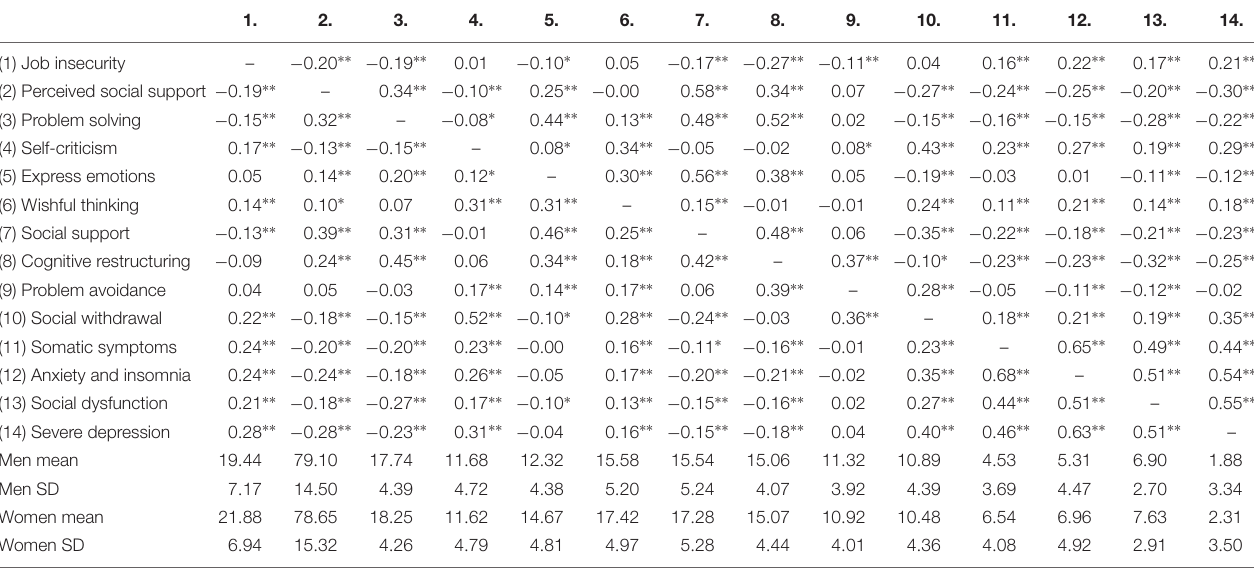
TABLE 2 | Correlations, means, and Standard Deviations of the variable included in the study by gender. 1. 2. 3. 4.